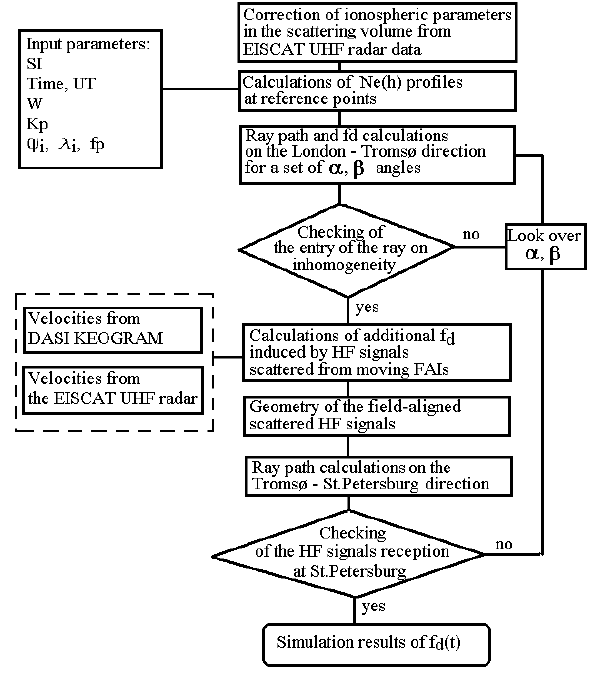
Fig. 4. Schematic of the algorithm of the CONE radio channel model.The following designations are used: SI - solar declination (day number of year); W - Wolf number; K p - planetary index of magnetic activity; φ i ,λ i - geographical coordinates of transmitter, receiver and the scattering region; f p - operational frequency; f d - Doppler frequency shift; α,β - angles of the radiation in the verti- cal (elevation) and horizontal (azimuth) plane, respectively; FAIs - field-aligned